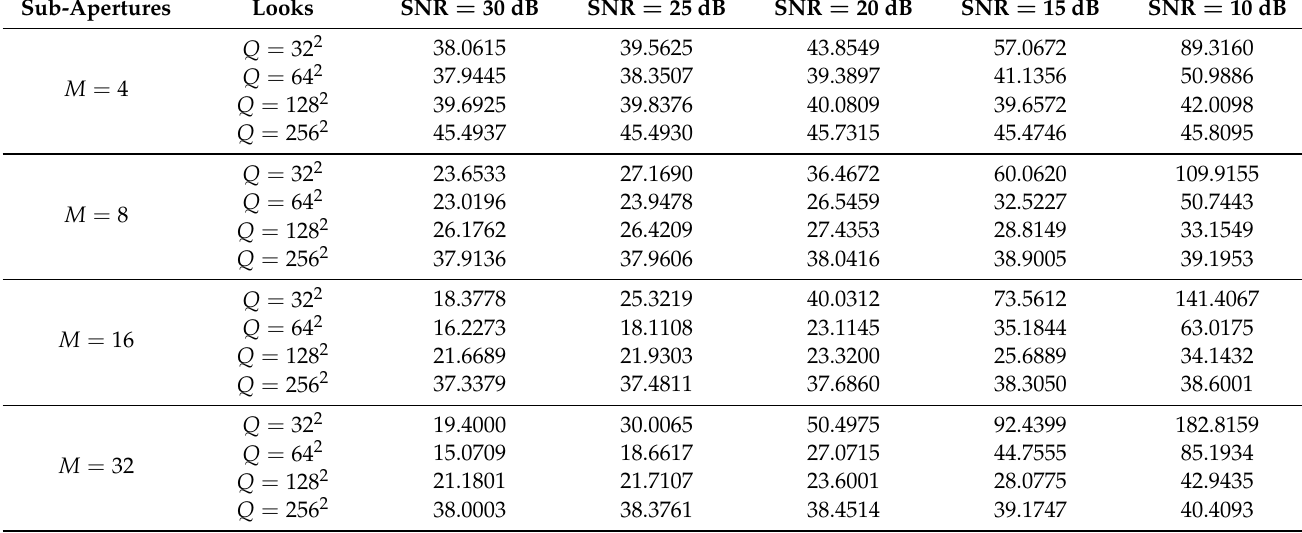
Table 4. The STD of the difference between the simulated and estimated PS-SPEs (Unit: deg).